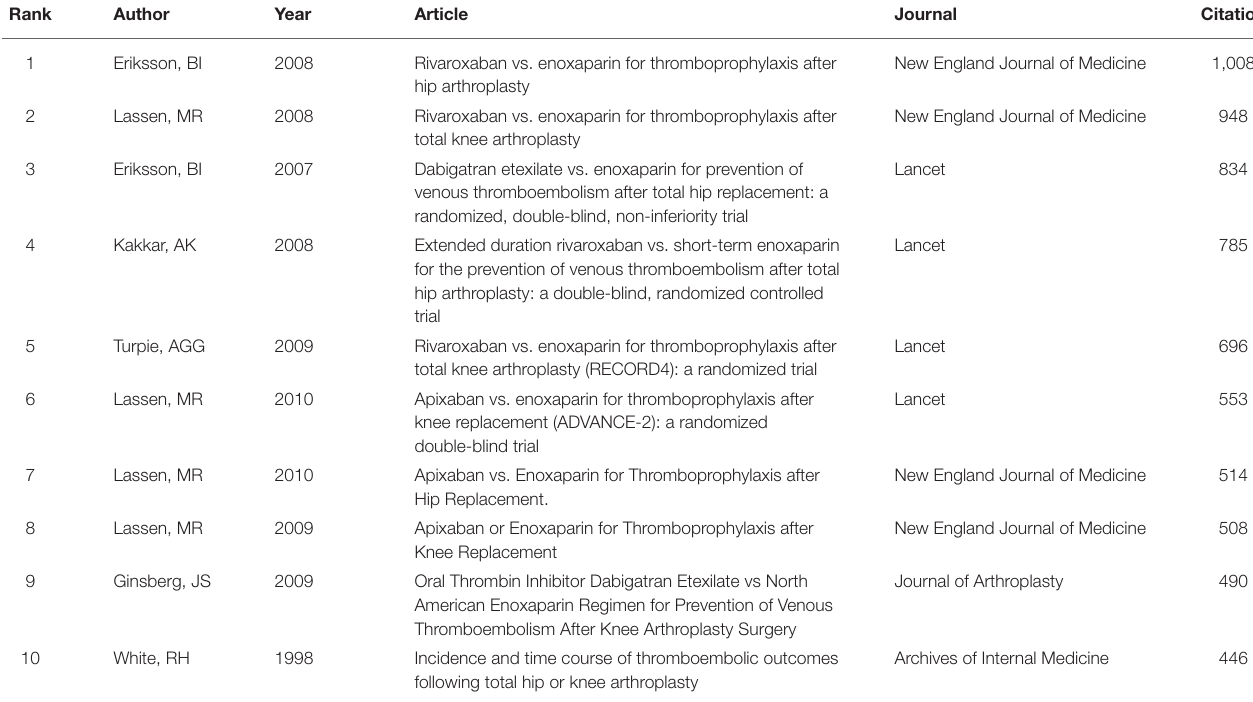
TABLE 5 | Top 10 high-cited articles related to venous thrombosis after hip or knee arthroplasty.